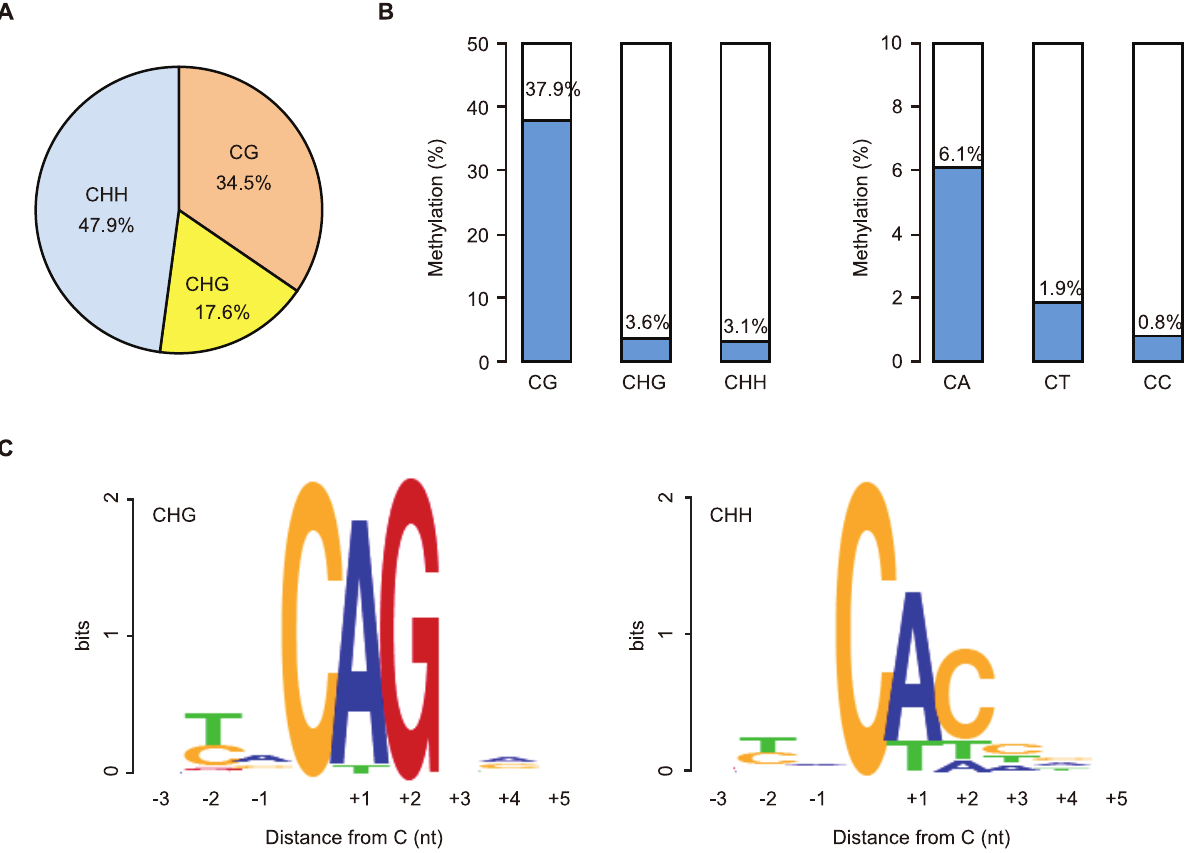
Figure 1. Abundant non-CG methylation in GVOs. (A) Proportions of mCs in contexts of CG, CHG, and CHH. Data for mCs at positions covered at least 4 6 on the same strand were used, and those with more than 100 6 coverage were excluded. (B) Levels of methylation at CG and non-CG sites. Non-CG sites were further divided into different tri- (CHG and CHH) and di-nucleotide sequences (CA, CT, and CC). (C) Bases neighboring the highly methylated ( $ 30%) non-CG sites.